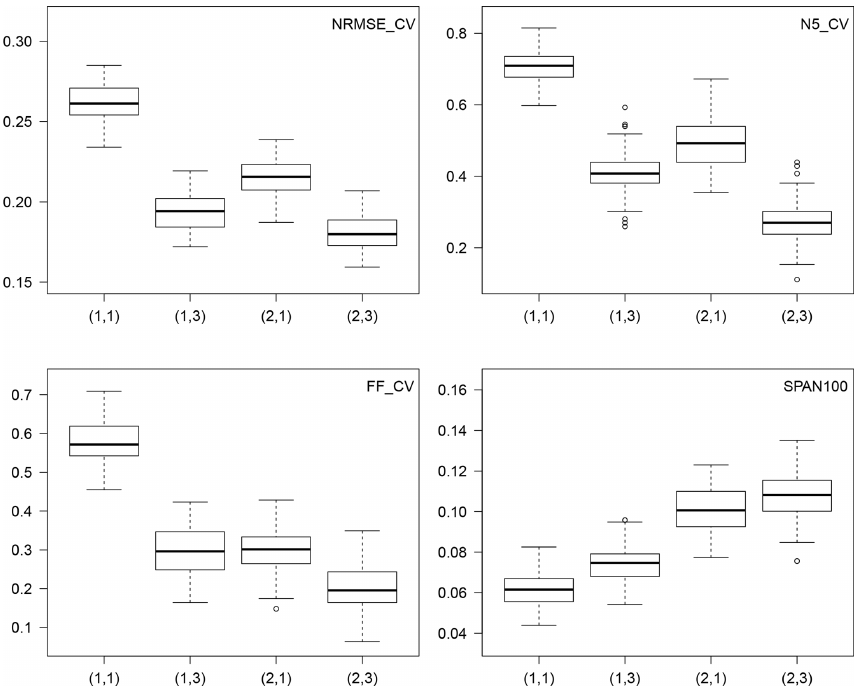
Figure 6. Scores of cross-validation when G s,k are Gamma distributions and the number of seasons and WP varies: S ∈ { 1, 2 } and K ∈ { 1, 3 } . The values of ( S , K ) are indicated in the x labels. Each boxplot contains 100